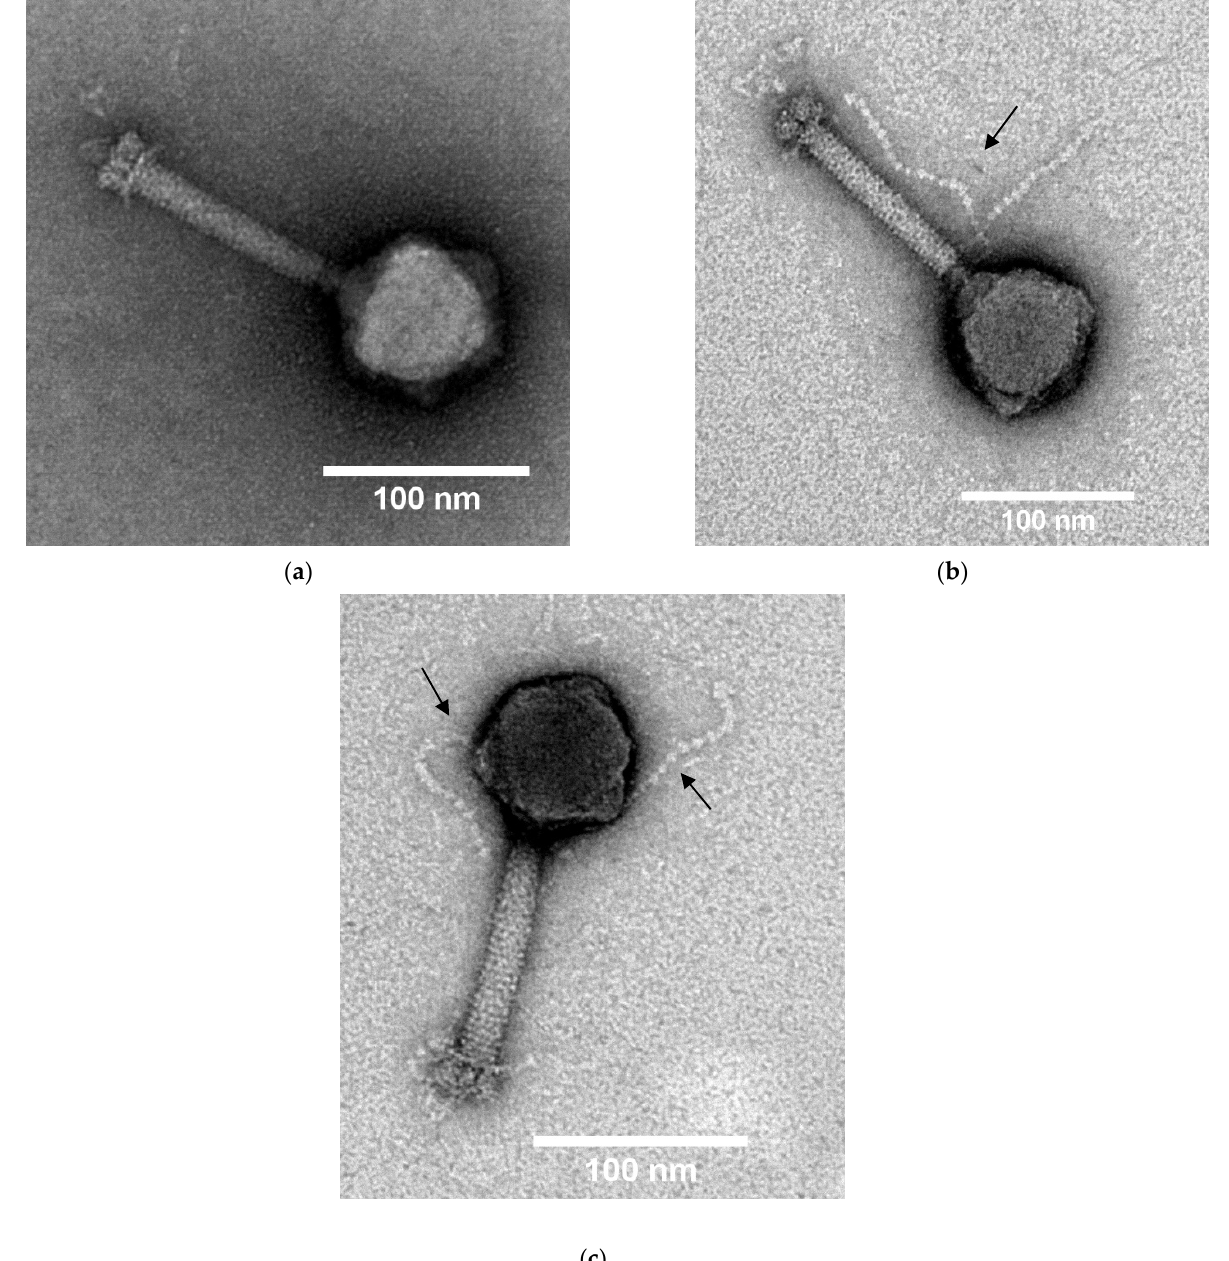
Figure 2. Transmission electron micrographs of the Ps15 phage particles stained with 2% ( w/v ) uranyl acetate displaying the Myoviridae morphotype. Magnification × 60 K. The extensions from a tail ( b ) and a capsid ( c ) are indicated by arrows. Note the specimens with straight short fibres ( a ) and their transformation into globular-looking forms ( b ). Scale bars are included for each image.